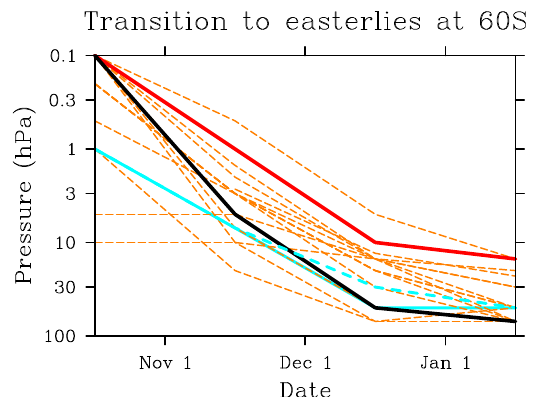
Fig. 2. Date of transition to easterlies at 60 ◦ S computed from the climatological (1980–2001) monthly zonal-mean zonal winds, for ERA-40 (cyan solid line), ERA-Interim (dashed cyan line), CNRM-ACM (red line), CNRM-CCM (black line) and CCMVal-2 REF-B1 models (dashed orange lines).